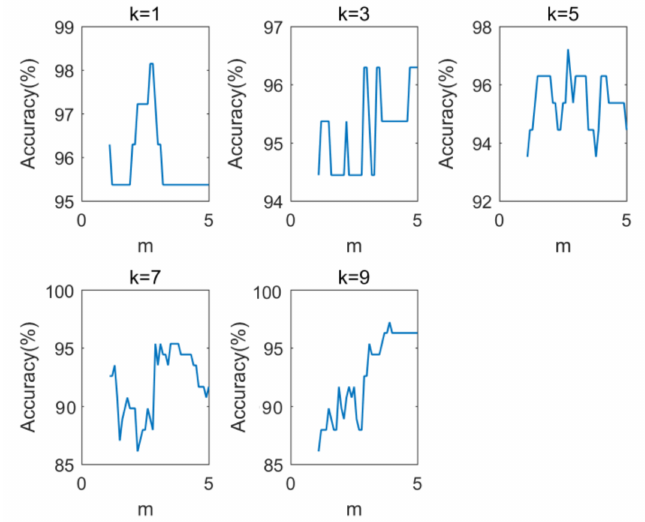
Figure 4. Accuracies of FMLDA under different k and m values.